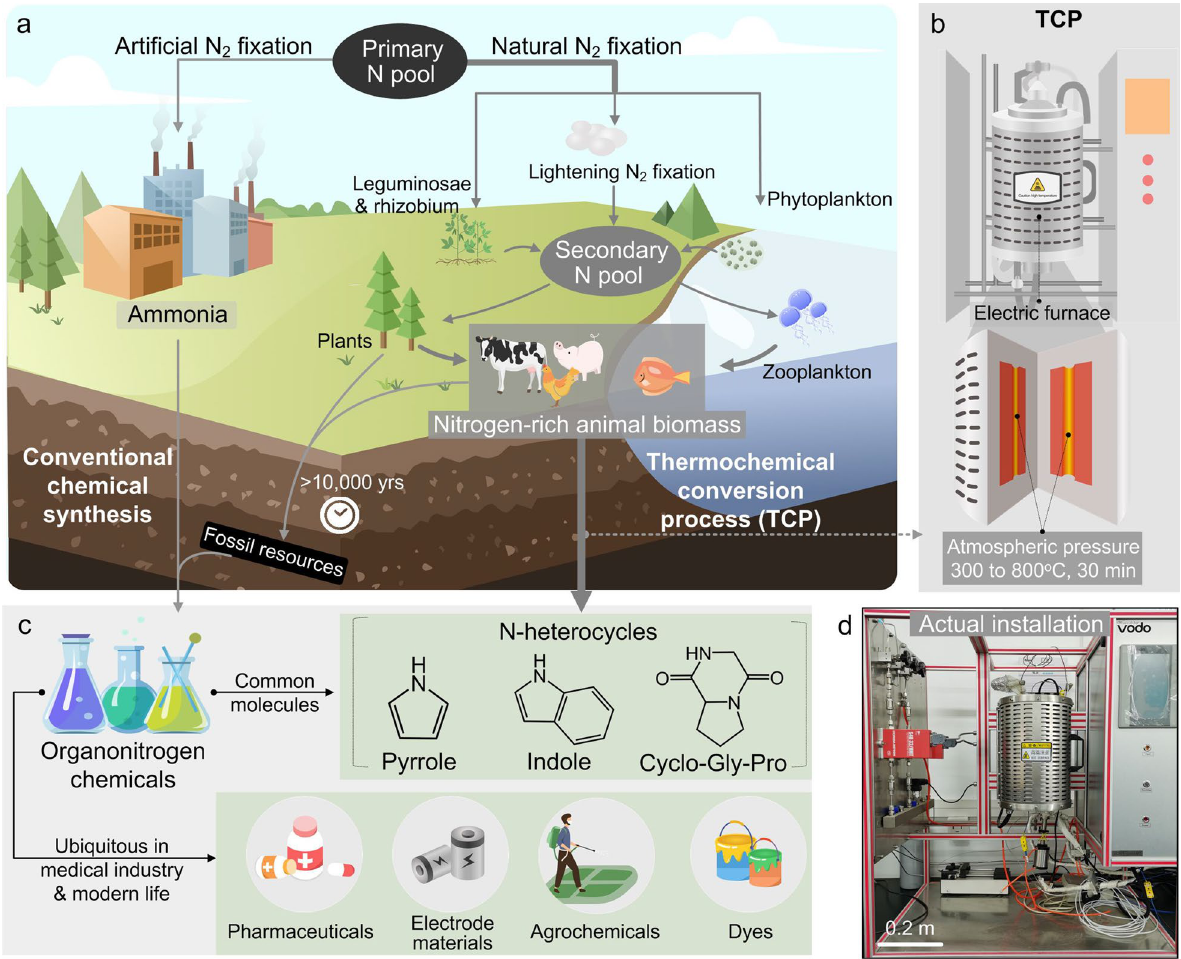
Fig. 1 Comparison between the conventional two-step route and the one-step animal biomass-dependent TCP route to generate N-heterocycles. a Schematic illustration of organonitrogen synthesis using TCP compared with the traditional chemical synthesis based on artificial N 2 fixation and fossil resources conversion (based on the Haber–Bosch process). b Schematic of the internal structure of the TCP device with the controlled temperature from 300 to 800 °C under atmospheric pressure. c Molecular structures and industrial applications of representative obtained N-heterocycles. d Optical photographic image of the installation of an actual TCP